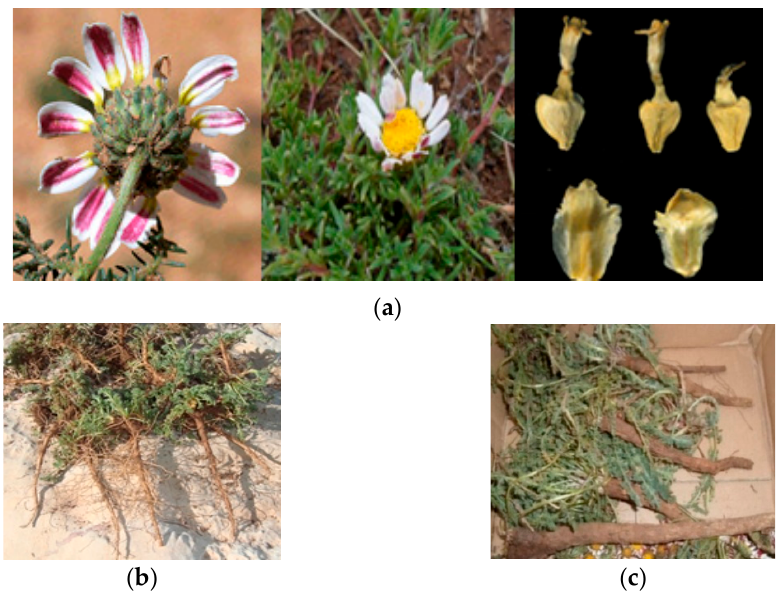
Figure 1. Morphological appearance: Flowers, ray florets and achene of A. pyrethrum ( a ), A. pyrethrum var. depressus ‘Tigendast’ roots ( b ) and A. pyrethrum var. pyrethrum ‘Igendas’ roots ( c ).